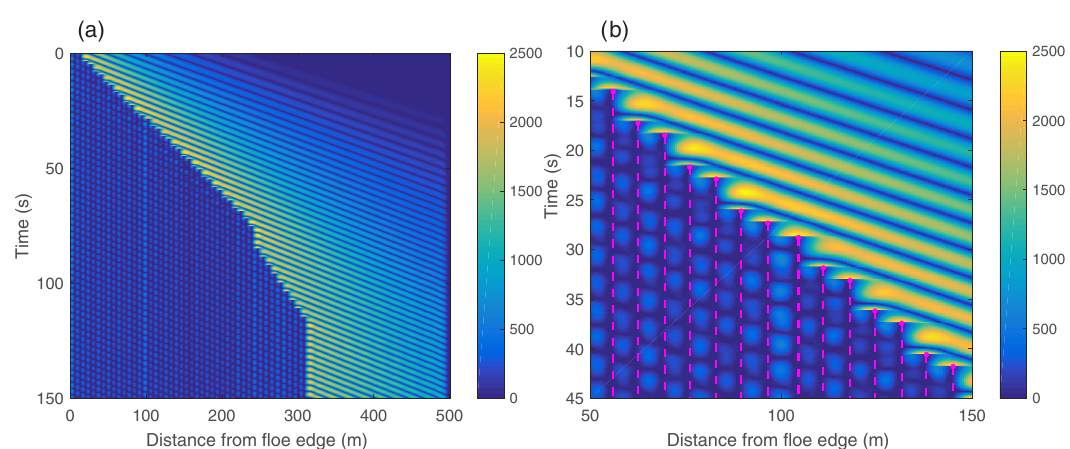
Figure 8. Simulated space–time variability of the tensile stress σ t (Pa) for an ice floe with length L o = 500m undergoing progressive breaking; ice thickness is h i = 0 . 5m, open-water wavelength is L w , 0 = 42m, and bond strength 2500Pa. The plot in panel (b) is a subset of that in panel (a) ; breaking events are marked with magenta dots and broken bonds with dashed lines.